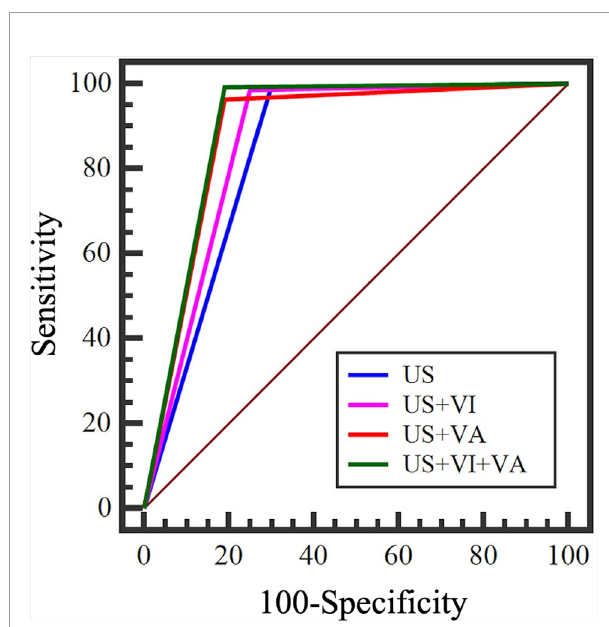
FIGURE 6 | ROC curve of conventional ultrasound combined with SMI.